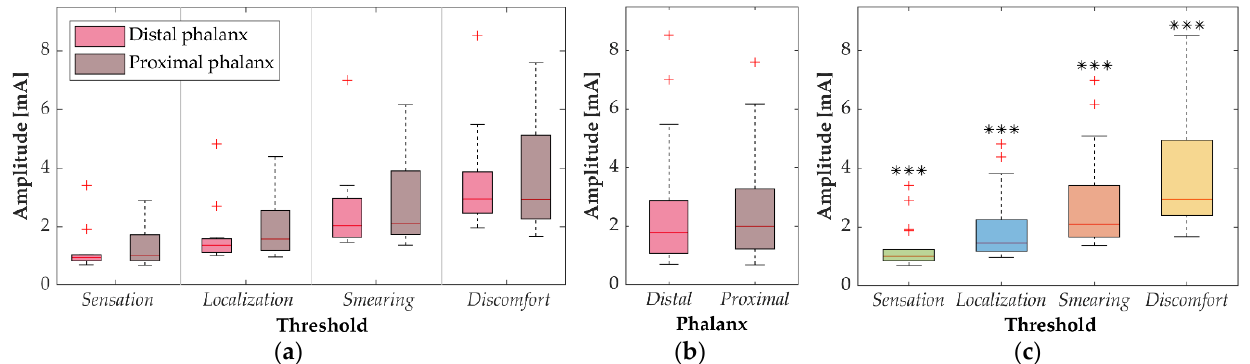
Figure 2. ( a ) Sensation (ST), localization (LT), smearing (SMT) and discomfort (DT) thresholds on distal (pink) and proximal (brown) phalanx, averaged across the six pads of the multi-pad electrode; ( b ) Main effect of the phalange—current amplitudes for distal (pink) and proximal (brown) phalanx averaged across thresholds; ( c ) Main effect of the threshold—ST, LT, SMT and DT averaged across phalanx. The red line, box, whiskers and red mark indicate the median, interquartile range upper/lower boundaries and outlier, respectively. The statistically significant differences were present between all four thresholds (***, p < 0.001).